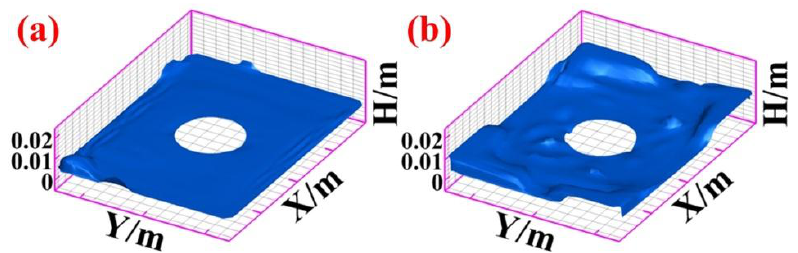
Figure 8. Comparison of three dimensional level fluctuations in the mold without ( a ) and with ( b ) EMS.